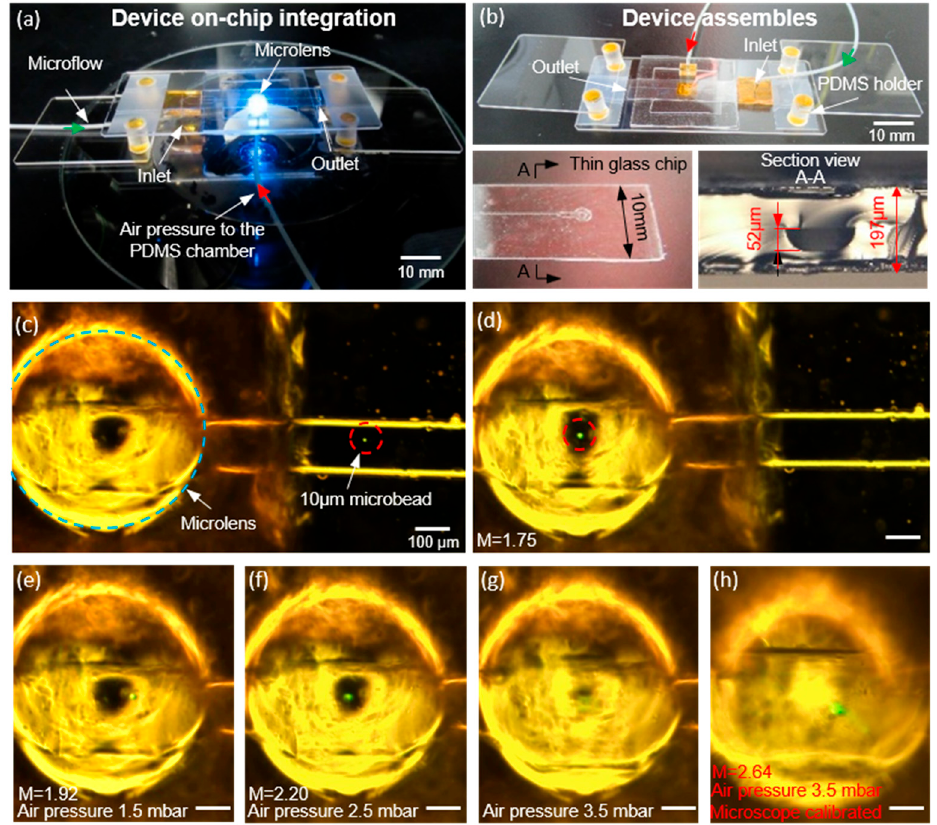
Figure 7. The on-chip optical system and some experimental results. ( a ) The device setup under the microscope; air pressure was supplied into the PDMS chamber via the tube marked by the red arrow. The green arrow points to the tube with fluorescent microbeads flowing into the microchannel. ( b ) The device assembly. ( c ) Images of the microscope focus calibrated on the glass chip. ( d ) Microbeads flowing in the microlens in an image that was obtained without any calibrations or application of air pressure into the PDMS chamber. ( e – h ) Images of the microbeads at di ff erent magnified sizes when di ff erent air pressures were applied to the PDMS